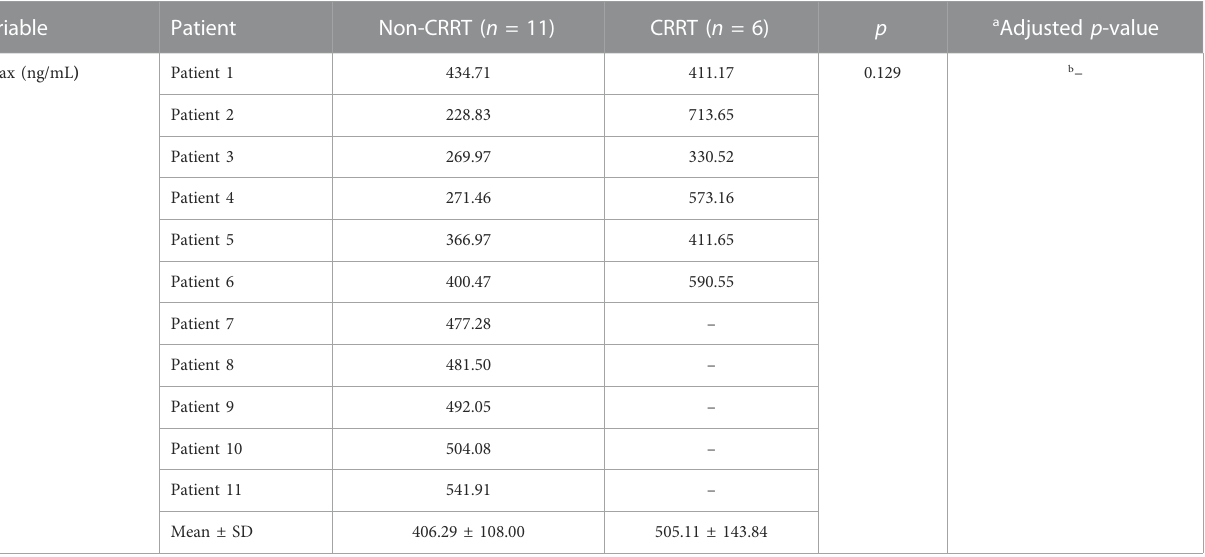
TABLE 2 Peak concentration of tigecycline in septic shock